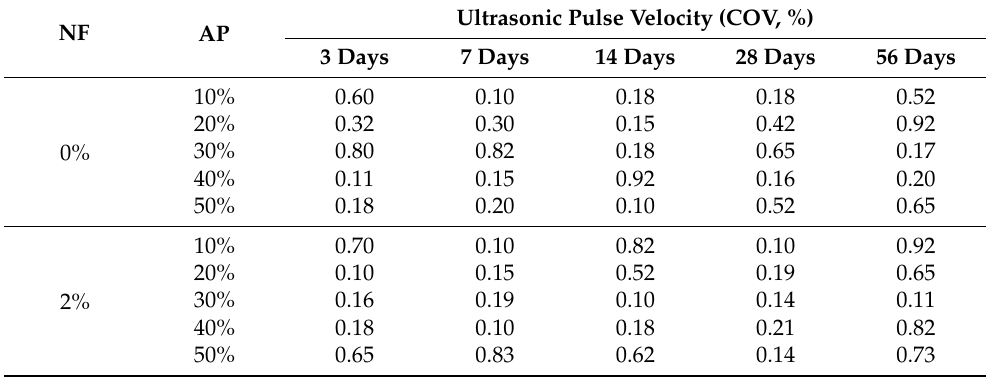
Table 7. Coefficient of variation for ultrasonic pulse velocity